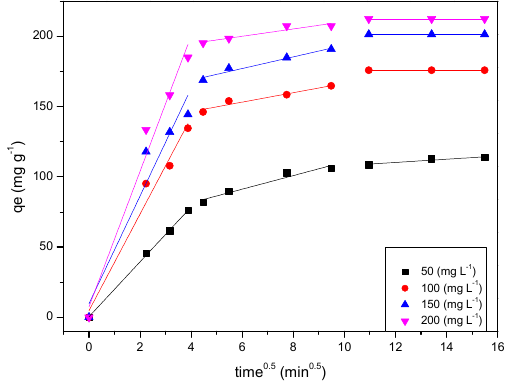
Figure 8. Intra-particle diffusion kinetics of MB dye adsorption on RF/TiO 2.